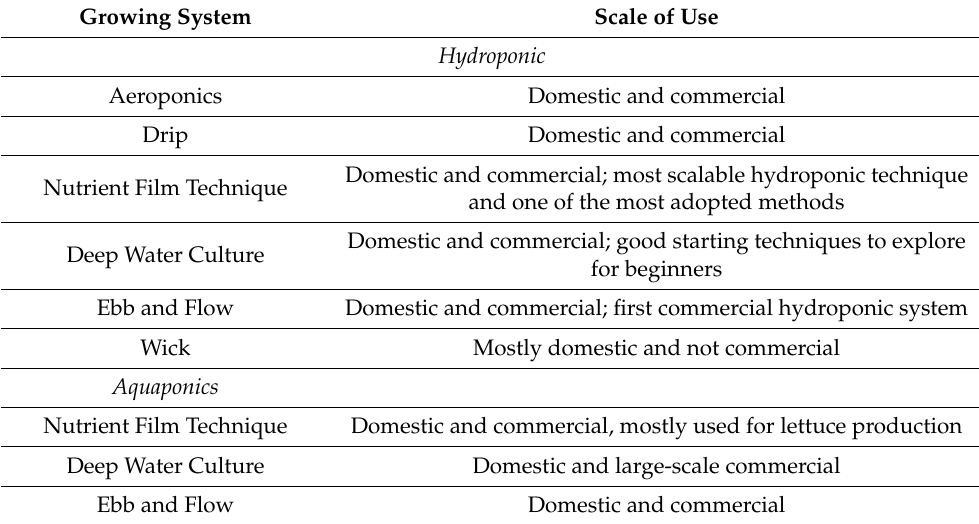
Table 6. Scales of use of hydroponic and aquaponic growing